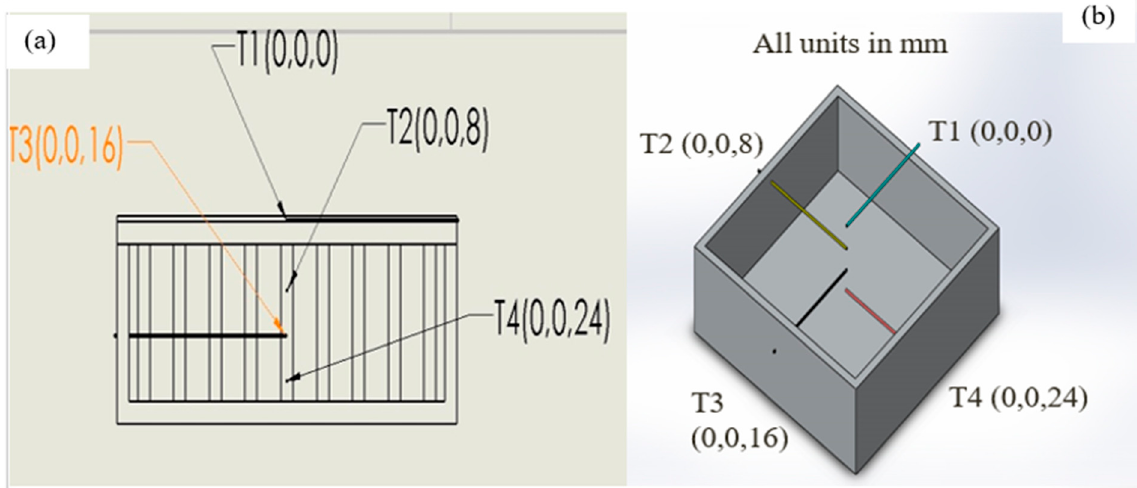
Figure 3. ( a ) Front view of thermocouples; ( b ) thermocouples coordinated in heat sink.